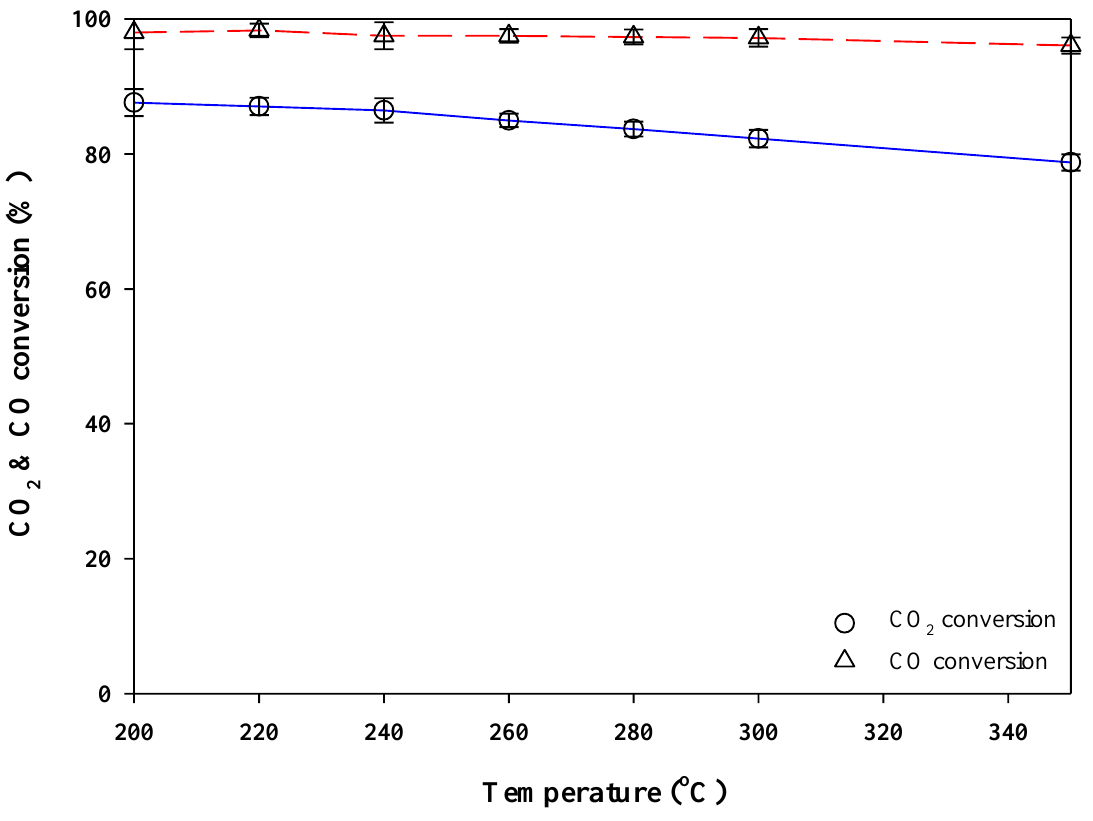
Figure 7. Result of COx methanation: At the ratio of inlet gases H 2 :CO 2 = 4:1 to H 2 :CO = 3:1.